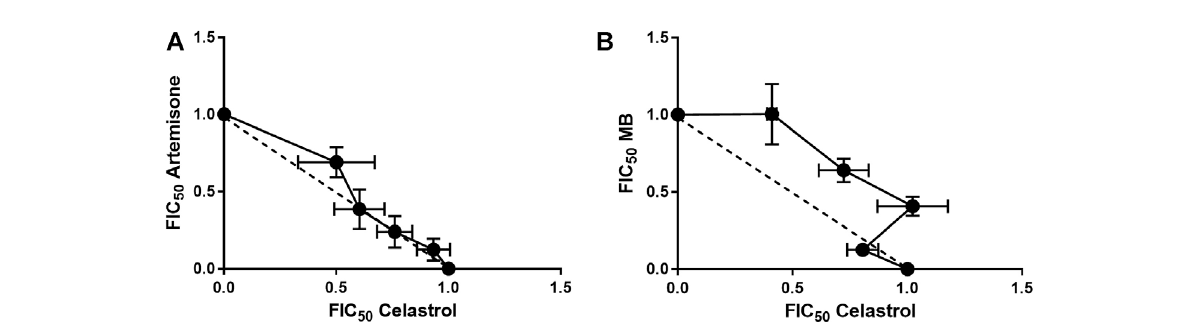
FIGURE 5 Isoboles for artemisone andMBincombinationwith celastrol. Isobole analysiswasperformedfor (A) :artemisone incombinationwith celastrol